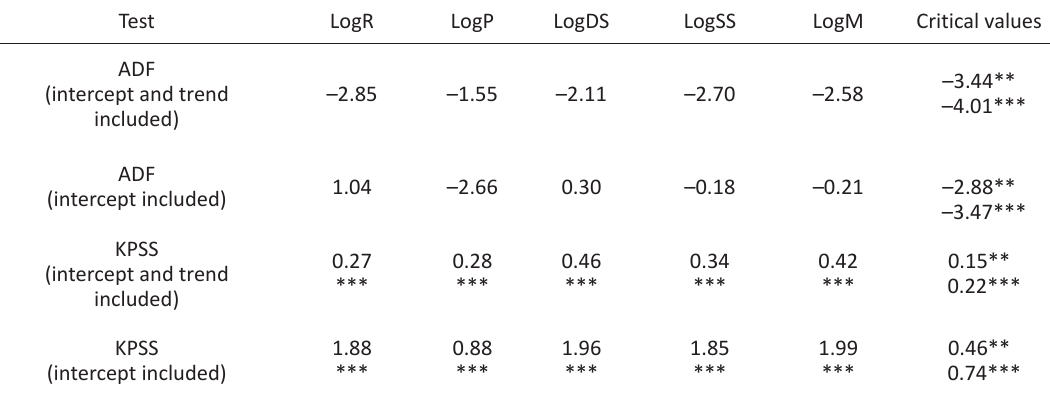
Table 2. Unit root test result of individual price